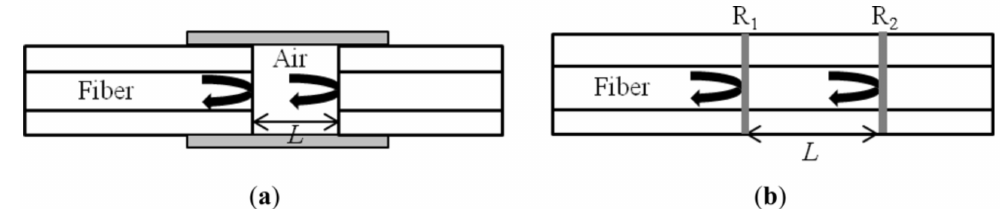
Figure 6. ( a ) Extrinsic FPI sensor formed by an external air cavity and ( b ) intrinsic FPI sensor formed by two reflecting components, R1 and R2, along a fiber. Reprinted from Ref. [60].